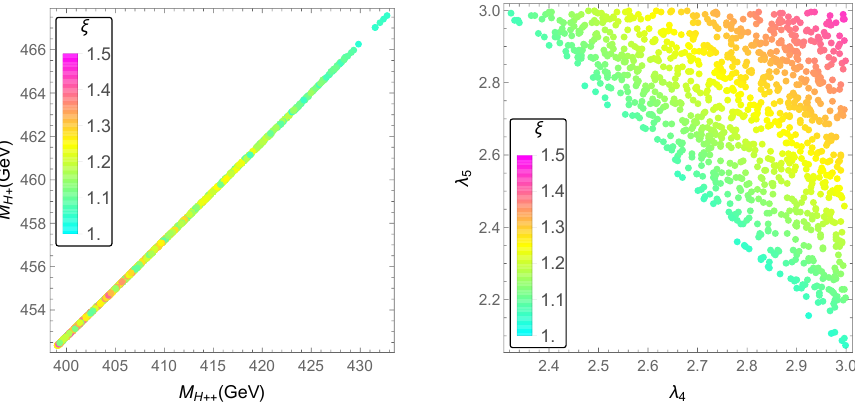
Figure 5 . Left panel: same as the bottom-left of figure 3 but for our setup 4; Right panel: the explicitly value of ξ on the plane of λ